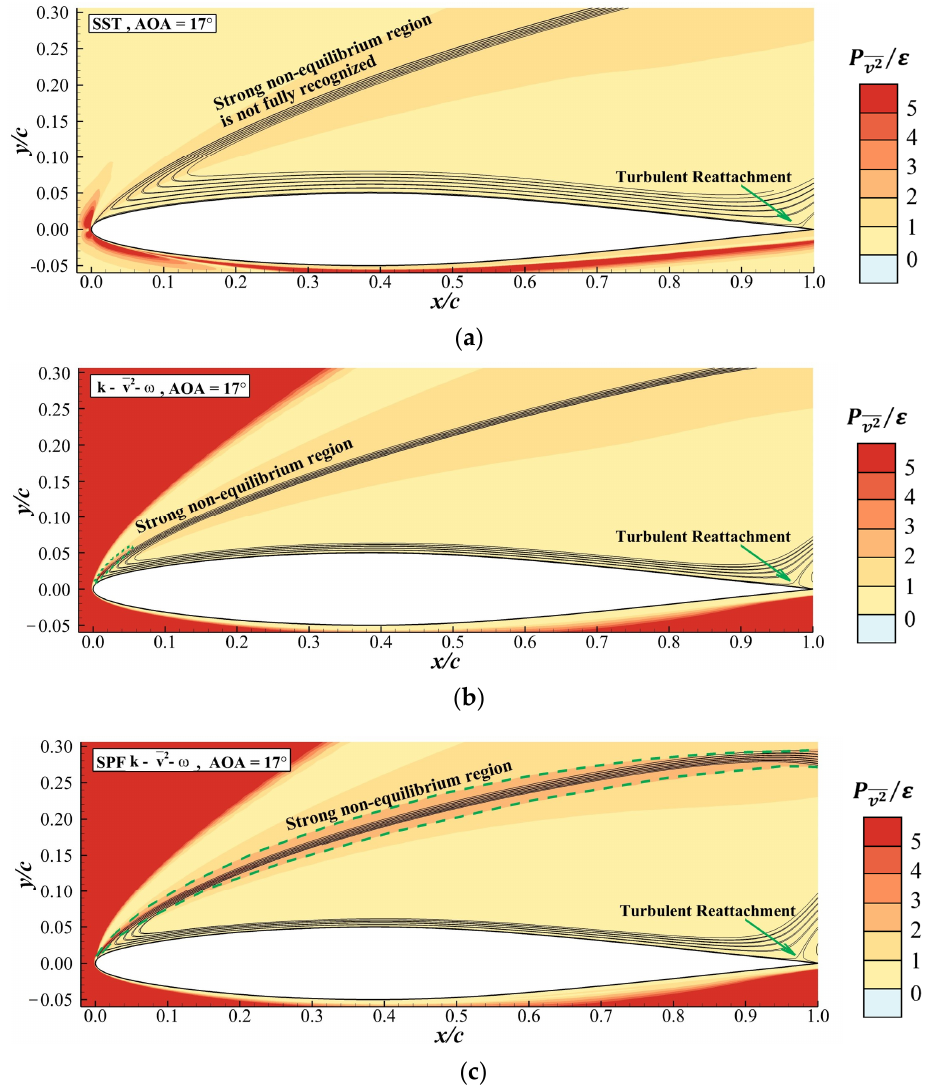
𝜀⁄ contour at 𝐴𝑂𝐴 = 17°,𝑅𝑒 = 3 × 10 (cid:2873) and 𝑀𝑎 = 0.12 . The non-equilibrium region Figure 8. 𝑃 (cid:3049) (cid:3118) (cid:3364)(cid:3364)(cid:3364)(cid:3364) Figure 8. P / ε contour at AOA = 17 ◦ , Re = 3 × 10 5 and Ma = 0.12. The non-equilibrium region v 2 and the separation point are marked in the figure. (a) SST model. (b) 𝑘 − 𝑣 (cid:2870) (cid:3364)(cid:3364)(cid:3364) − 𝜔 model. (c) SPF and the separation point are marked in the figure. ( a ) SST model. ( b ) k − v 2 − ω model. ( c ) SPF model.